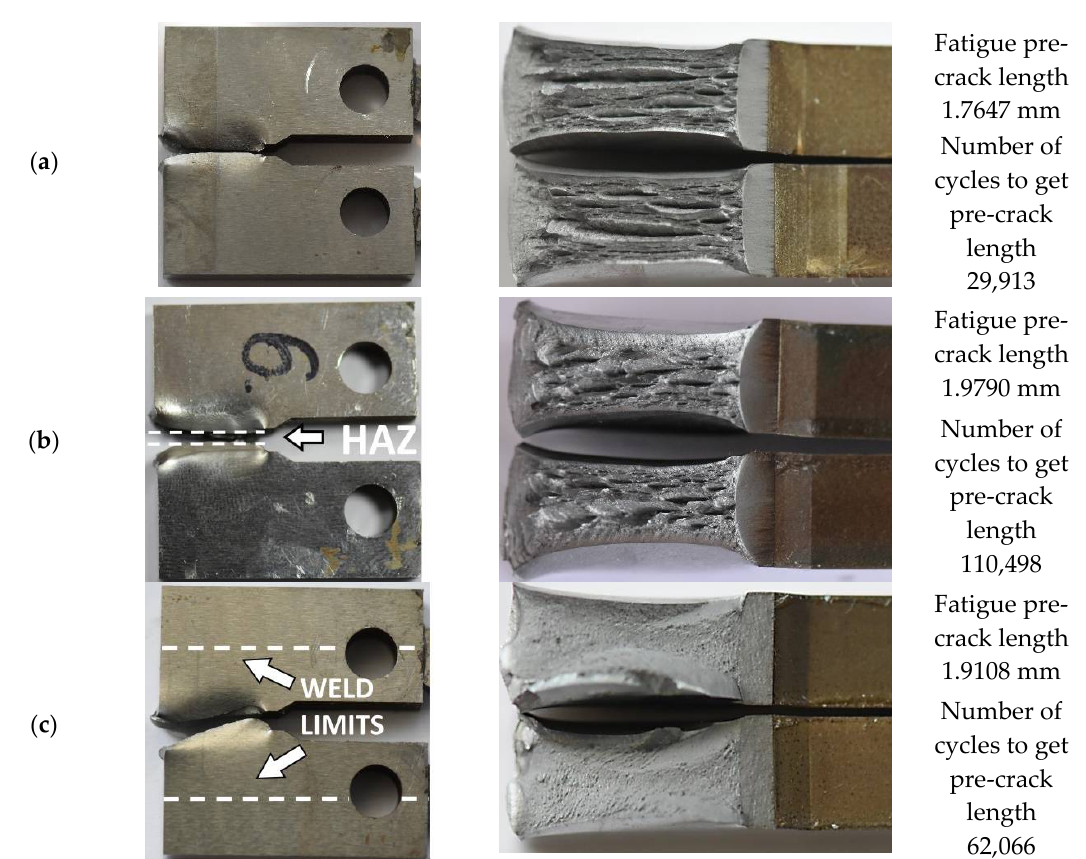
Figure 13. CT mini-specimens at the final stage of CTOD tests: ( a ) parent material; ( b ) HAZ; ( c ) weld.